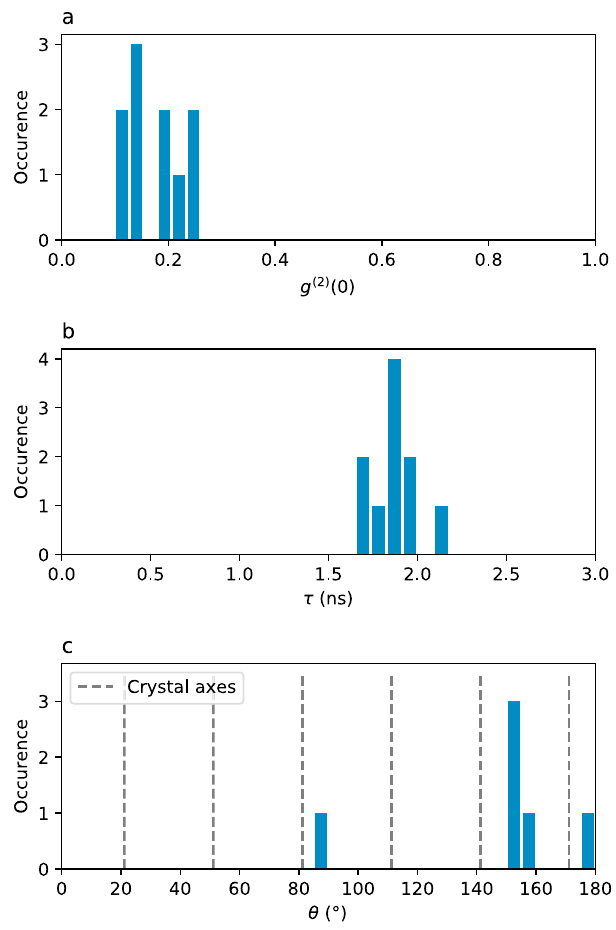
Fig. 3 Statistical dispersion of individual SPE properties. a g (2) (0) of 10 SPEs, showing single-photon emission. b Fluorescence lifetime τ of the same 10 individual SPEs, with a mean value of 1.87 ns. c Polarization axis of the emission of 6 individual SPEs on the same fl ake, showing that most SPEs emit with a similar polarization